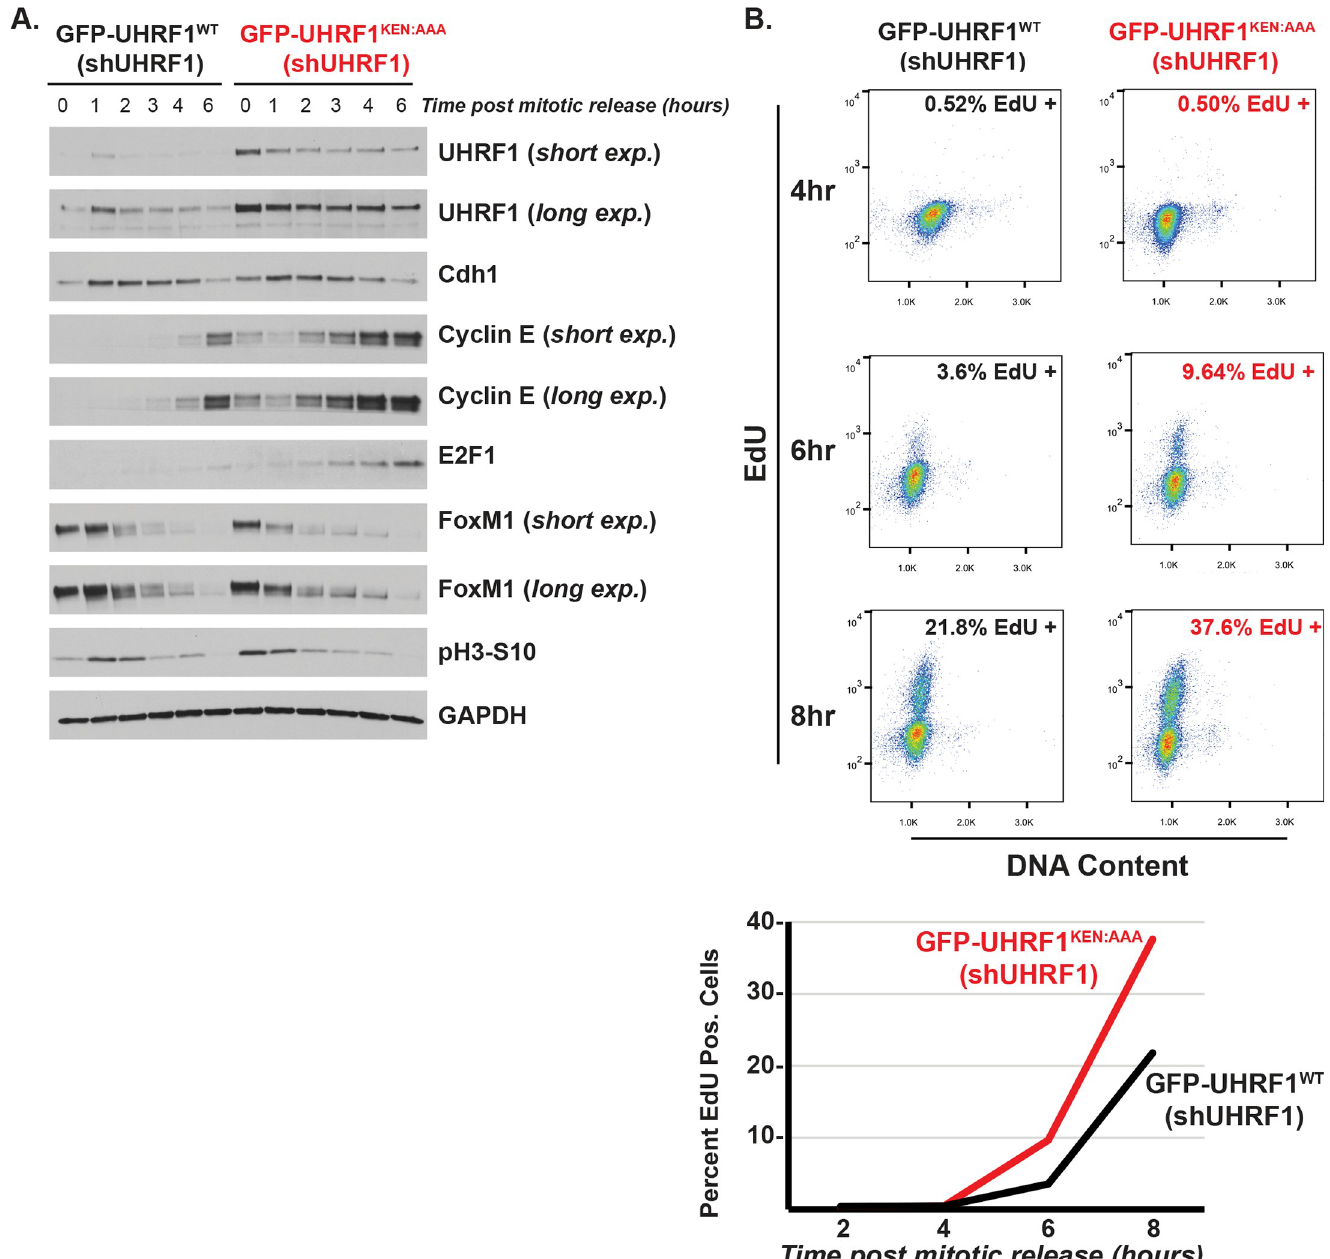
Fig 6. UHRF1 degradation restrains S-phase entry. (A) HeLa S3 stably expressing GFP-UHRF1 WT or GFP-UHRF1 KEN:AAA along with 3 0 UTR targeting shUHRF1 were synchronized in mitosis as described previously, released into the cell cycle, and collected for immunoblot analysis at the indicated time points, probing for cell cycle proteins as shown. Data representative of n = 3 experiments. (B) HeLa S3 stably expressing GFP-UHRF1 WT or GFP-UHRF1 KEN:AAA along with 3 0 UTR targeting shUHRF1 were synchronized in mitosis, released into the cell cycle, and pulsed with 10- μ M EdU for 30 min prior to harvest and analysis by flow cytometry. Data representative of n = 3 experiments. (S1 Data). UHRF1, ubiquitin-like with PHD and RING finger domains